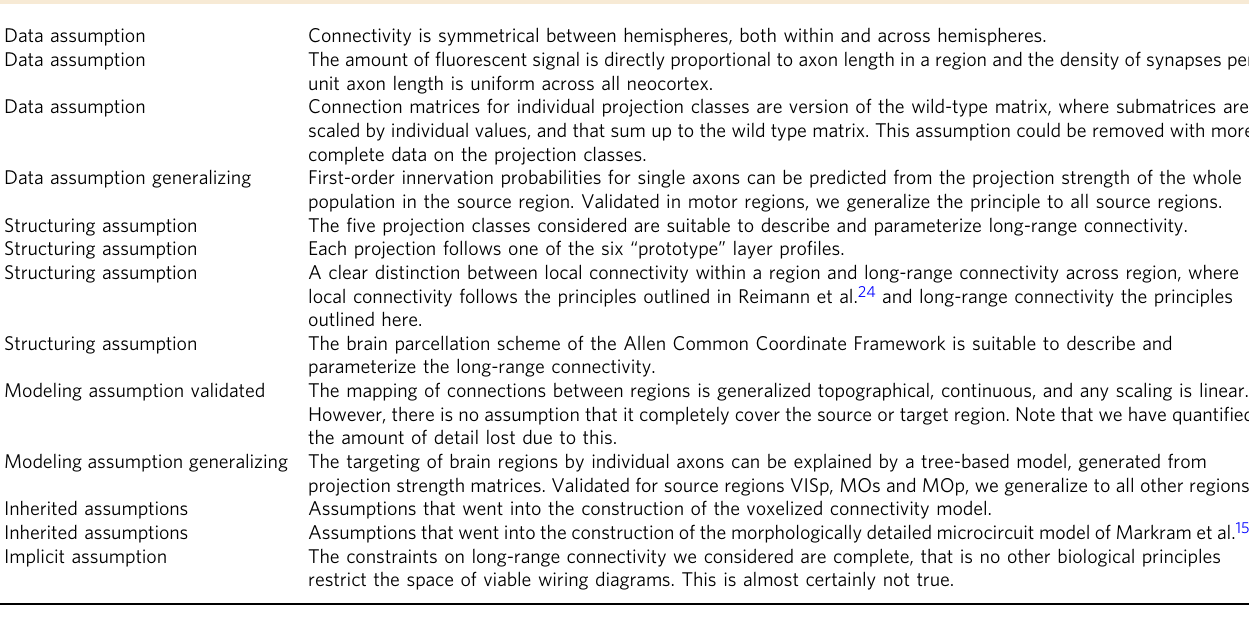
Table 2 List of assumptions used in the formulation of the model Data assumption Connectivity is symmetrical between hemispheres, both within and across hemispheres. Data assumption Data